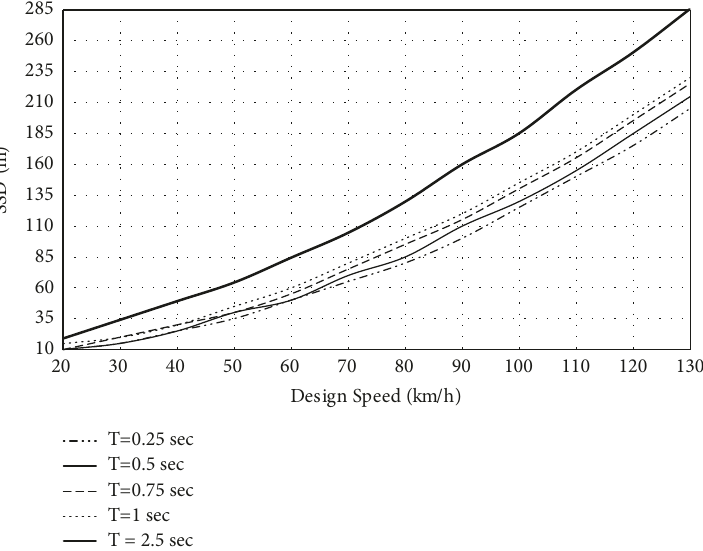
Figure 4: Variation of SSD for different PRTs.